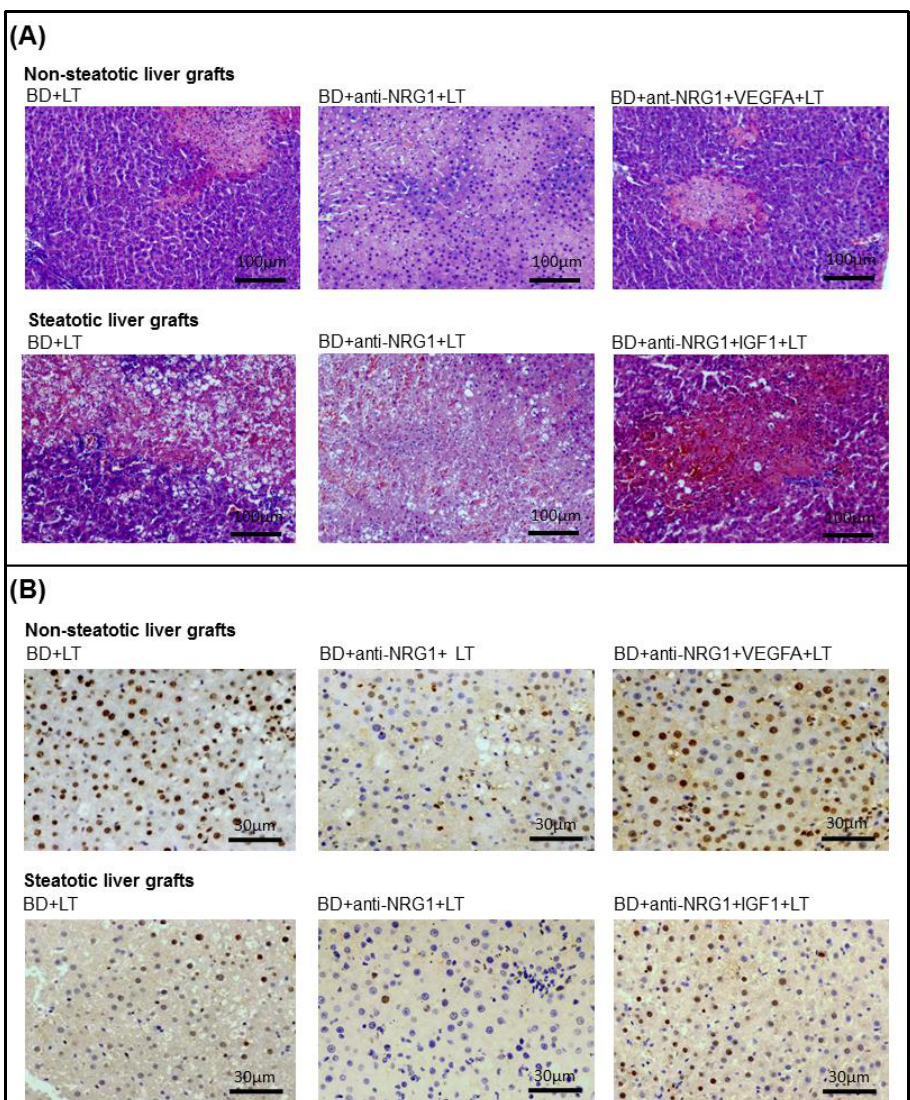
Figure 4. Representative photographs of histological changes and immunohistochemical staining of PCNA-positive cells in steatotic and non-steatotic LT from DBDs in a genetic obesity model. ( A ) Histological changes. In the BD+LT group, the histological evaluation of non-steatotic livers showed moderate multifocal areas of coagulative necrosis and neutrophil infiltration, randomly distributed throughout the parenchyma; severe, extensive, and confluent areas of coagulative necrosis were observed in the BD+anti-NRG1+LT group. When recombinant VEGFA was administered to the BD+anti-NRG1+LT group, liver tissue injury decreased, resulting in similar histological findings to those described in the BD+LT group. Steatotic liver grafts from BD+LT and BD+anti-NRG1+IGF1+LT showed extensive and confluent areas of coagulative necrosis, whereas the extent and the number of necrotic areas increased in the BD+anti-NRG1+LT group (4 × ). ( B ) Immunohistochemical staining of PCNA-positive cells. Non-steatotic liver grafts in the BD+anti-NRG1+LT group showed fewer positive cells than in the BD+LT and BD+anti-NRG1+VEGFA+LT groups. In steatotic liver grafts, fewer positive cells were observed in the BD+anti-NRG1+LT group in comparison with those in the BD+LT and BD+anti-NRG1+IGF1+LT experimental groups (20 ×